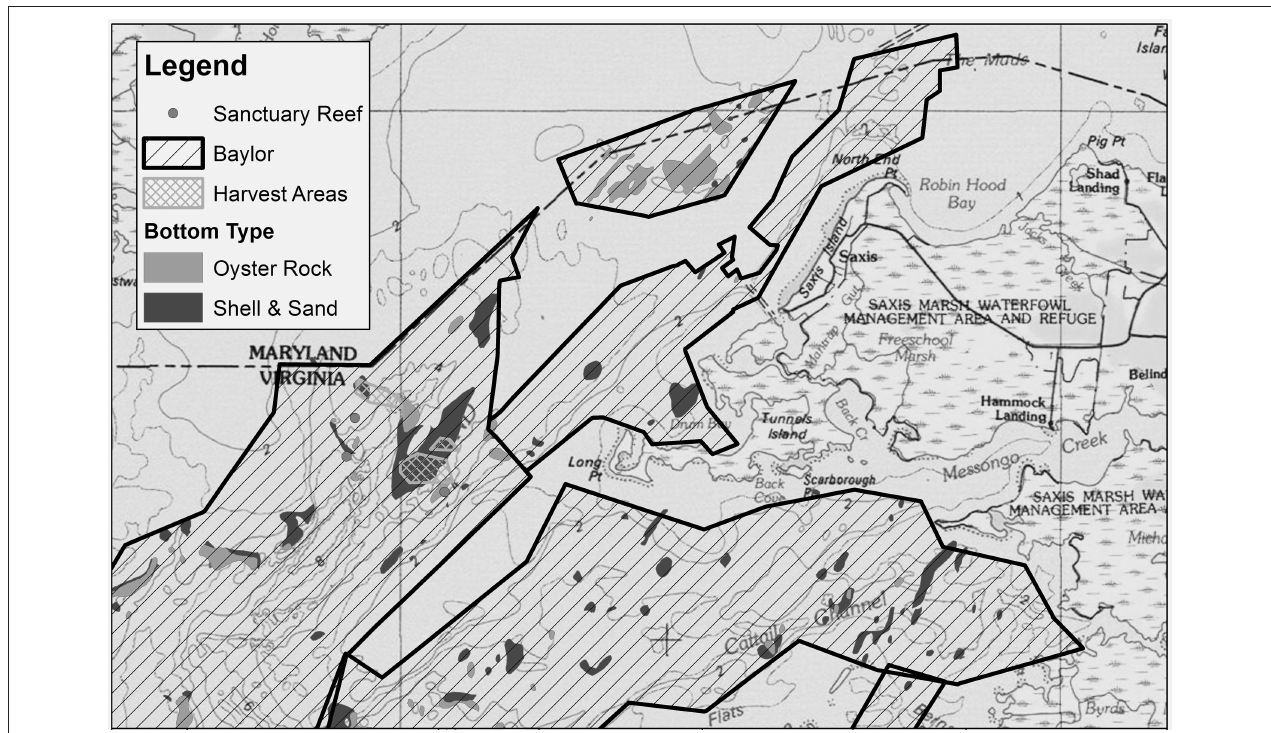
FIGURE 7 | Shell placement in Pocomoke Sound, 2002. Note a large portion of the shells were not placed on the highest quality “oyster rock” bottom areas.